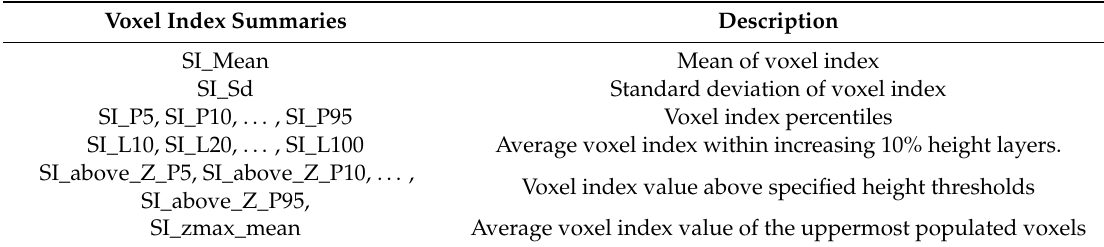
Table 5. List of metrics calculated using plot-level summaries of voxel vegetation indices, where SI is the computed spectral